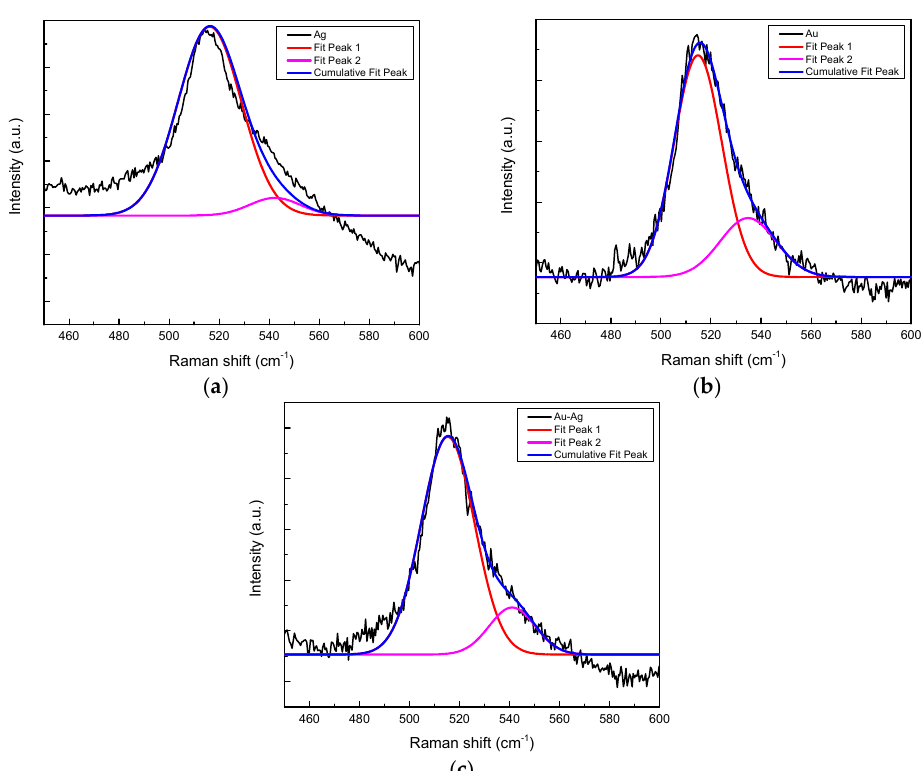
Figure 5. E g Vibrational mode of TiO 2 in anatase phase at 537 cm − 1 for ( a ) Ag, ( b ) Au and ( c ) AuAg modified thin films.